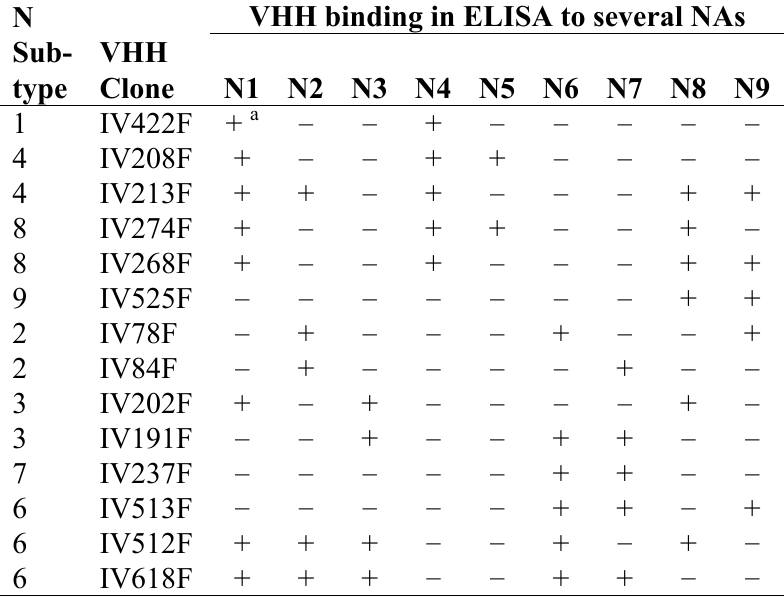
Table 7. Summary of VHHs that bind to at least two different NA subtypes in